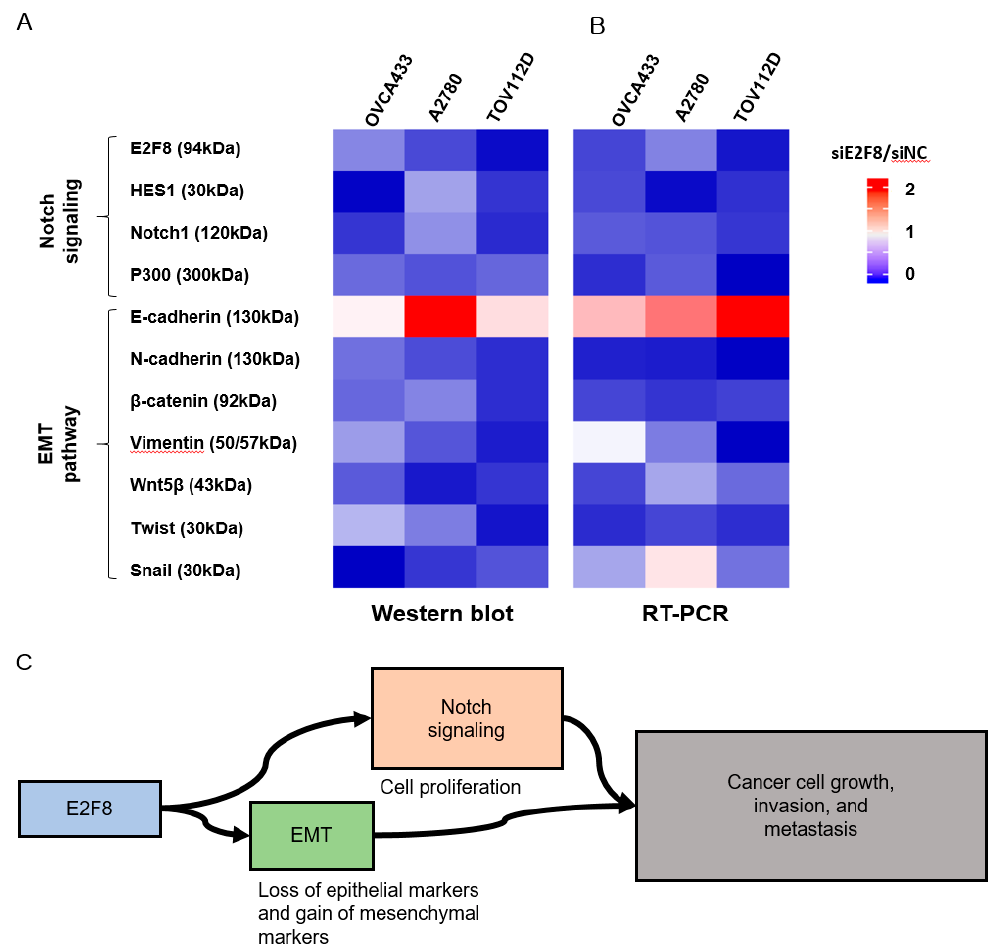
Figure 5. Effect of E2F8 knockdown on Notch and epithelial-mesenchymal transition (EMT) pathways. OVCA433, A2780, and TOV112D cells were transfected with siE2F8 and siNC for 48 h. Western blot ( A ) and Real-time RT-PCR ( B ) of Notch- and EMT-related genes after E2F8 knockdown in OVCA433, A2780, and TOV112D cells. The ratio of siE2F8- to siNC-treated expression in both protein and mRNA is presented in the heat map image. A ratio smaller than 1 meant that E2F8 E2F8 knockdown increased the expression (red). ( C ) E2F8 promotes tumor growth, invasion,